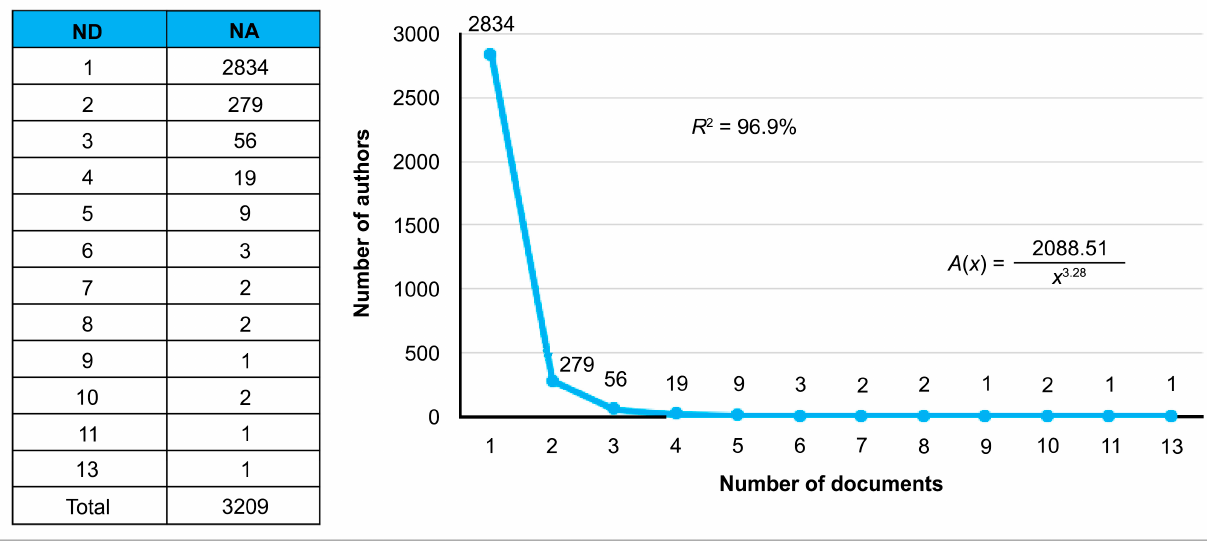
Table 5. Top 9 most productive authors by number of papers, institution, country, Scopus ID and